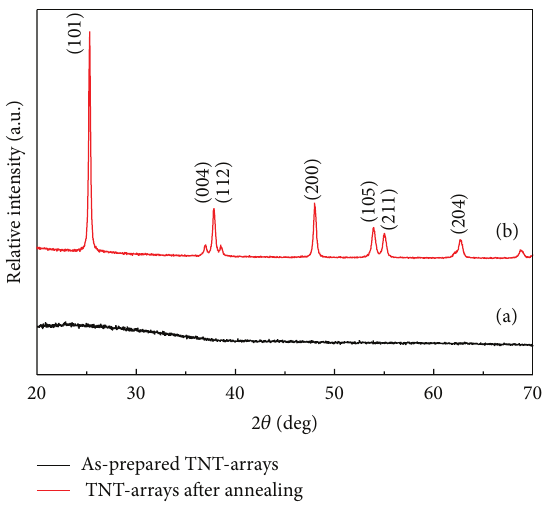
Figure 2: XRD patterns of as-prepared TNT-arrays (a) and TNT- arrays after annealing process at 450 ∘ C for 30min